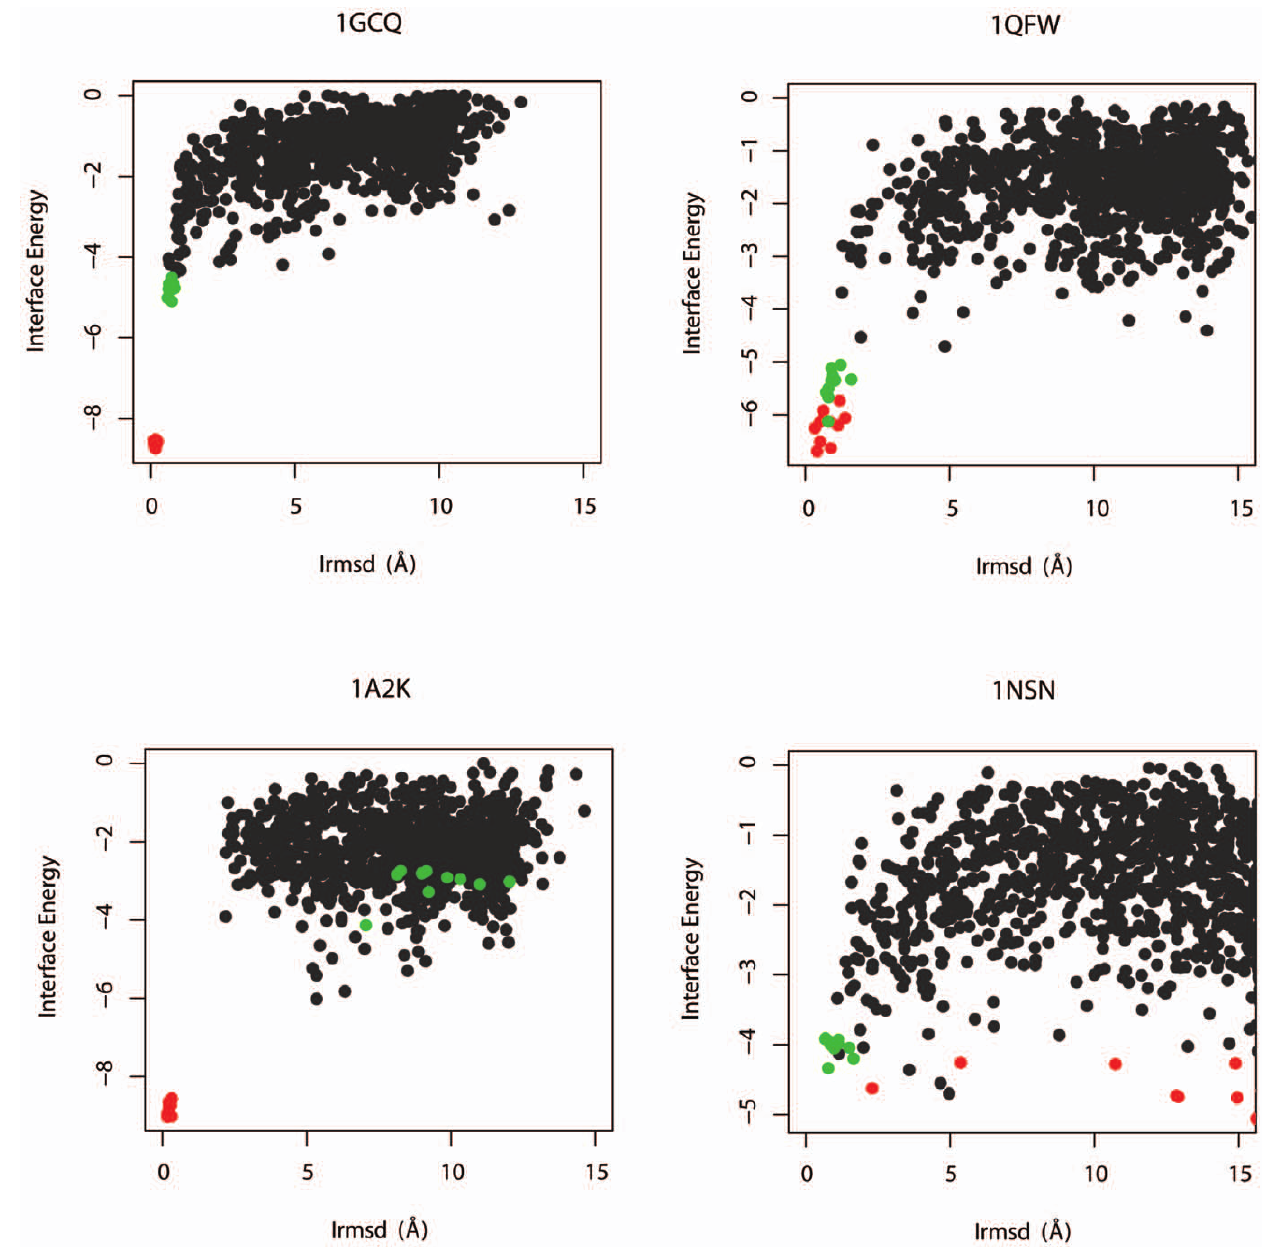
Figure 3. Examples of docking successes and failures. Interface energy vs. I_rmsd scatter plots for representative cases of (A) a docking success, (B) RB-sampling failure, (C) BB-sampling failure, and (D) a discrimination failure. Standard docking run decoys are in gray, the ten lowest- energy decoys from refinement of the unbound conformers superimposed on the native complex are in green, and the ten lowest-energy decoys from refinement of the bound complex is in red.